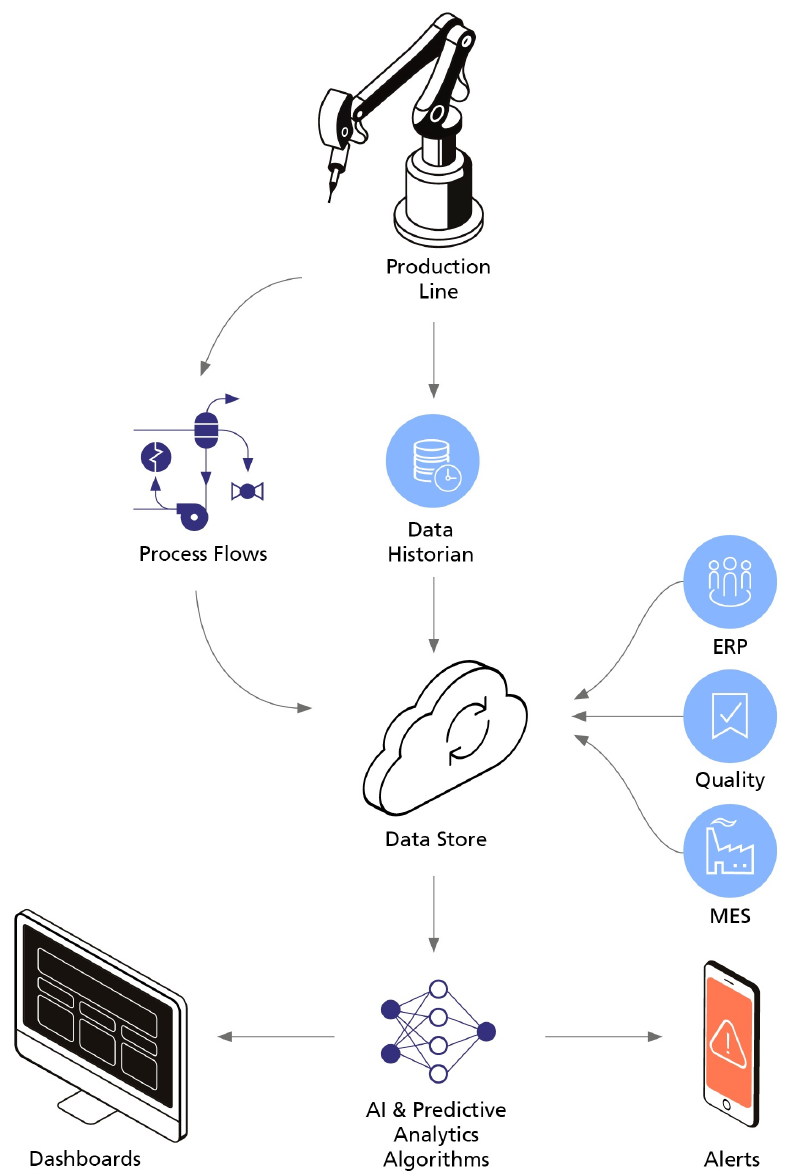
Figure 1. Predictive maintenance architecture (Adapted from